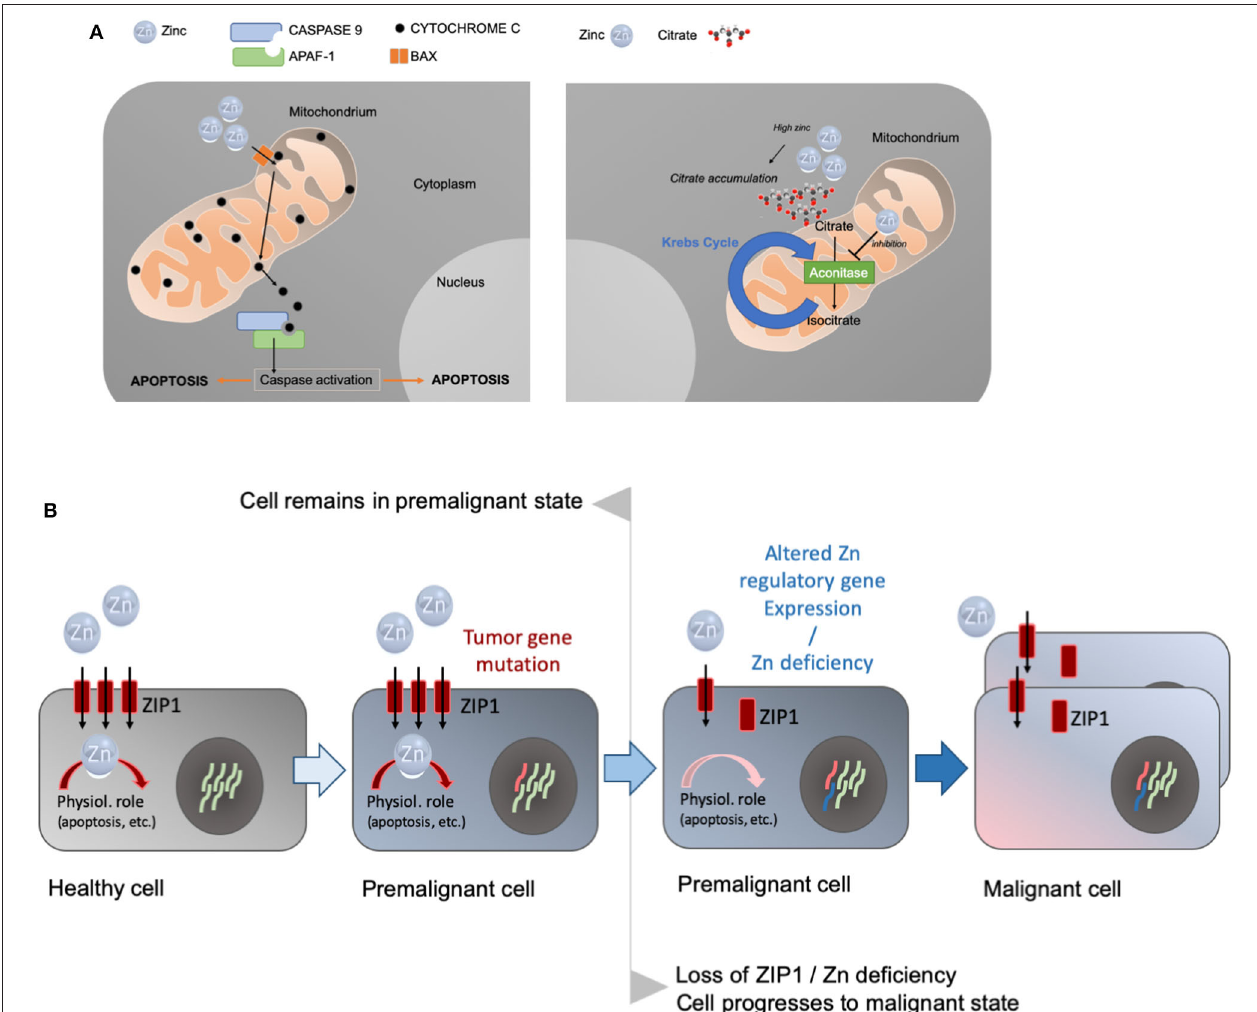
FIGURE 2 | (A) Prostate cells accumulate high levels of zinc. Zinc enters the mitochondria causing cytochrome c to be released from the mitochondria, triggering caspase activation and the induction of apoptosis (left panel). Alternatively, zinc can inhibit aconitase, the enzyme catalyzing the production of isocitrate from citrate in the Krebs cycle (right panel). This leads to the accumulation of high levels of citrate that is characteristic for prostate cells. (B) The concept of the oncogenetic and genetic/metabolic transformations in the carcinogenesis process, and the role of zinc and zinc transporters in the etiology of prostate cancer. Premalignant cells may have predisposing mutations in tumor genes. A decrease in zinc and/or decrease in the ZIP1 transporter in prostate cancer occur as early events in premalignant cells and precede malignancy. Zinc deficiency and/or the downregulation of zinc import proteins subsequently results in a malignant